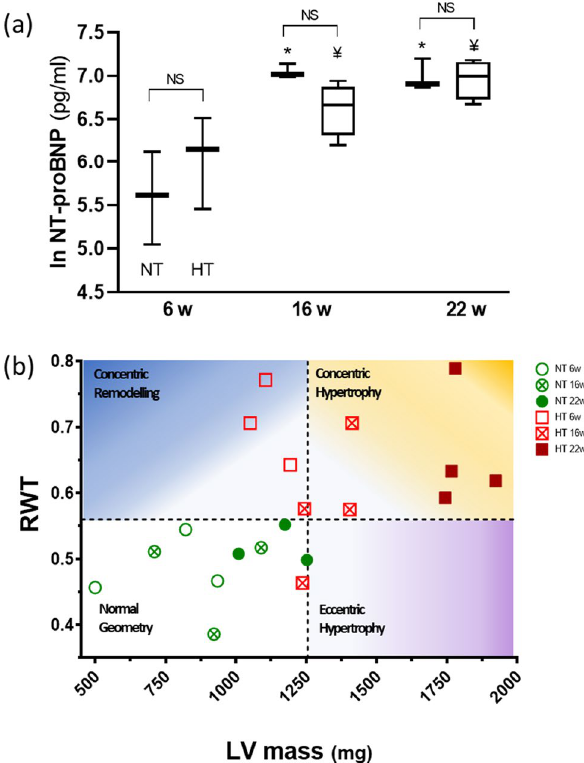
Figure 2. ( a ) Plasma NT-proBNP at 16 and 22 weeks increased in both normotensive (NT) and salt-fed (HT) Dahl/SS rats compared with baseline. * P ≤ 0.05 and ¥ ≤ 0.05 versus same group at 6 weeks. Data are paired as NT and HT (box and Tukey whiskers). ( b ) The relationship between LV mass and RWT was used to evaluate the type of remodeling that occurred in the Dahl/SS rats that were fed either NS or HS food. All rats that were fed a NS diet displayed a normal geometry (white, bottom-left quadrant). Rats that were fed a HS diet for six weeks had an increased RWT, indicating a concentric remodeling compared with NT rats. At 16 weeks of a HS diet, Dahl/SS rats showed signs of concentric hypertrophy, which was ultimately fully developed after 22 weeks of HS diet. LV mass indicates left ventricular mass; RWT, relative wall thickness; NT, normotensive Dahl/SS rat; and HT, hypertensive Dahl/SS